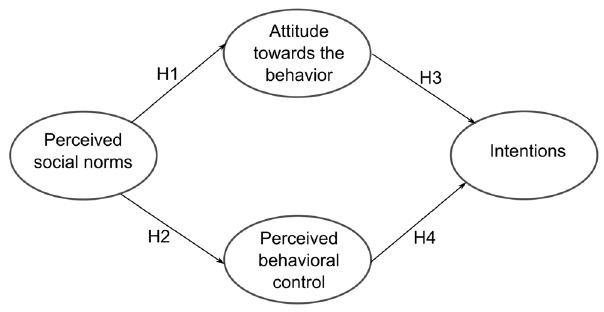
Figure 4. Sample of the conditioning intentionality Model.